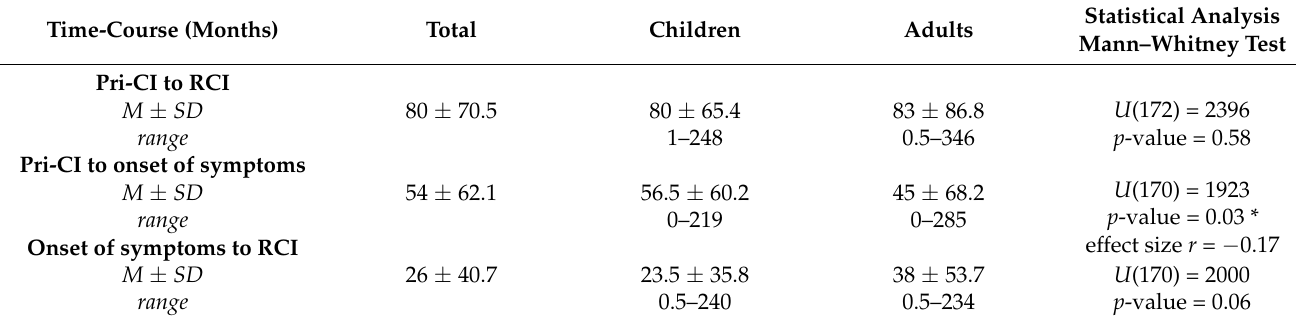
Table 2. Time-course intervals, including comparison between children and adults. Figure 1. The burden of RCI of the total number of CIs 1989–2018. There was a gradual increase through the 30-year time- course in the proportion of revision cochlear implantation (dashed line). CI—cochlear implant; RCI—revision cochlear implant.